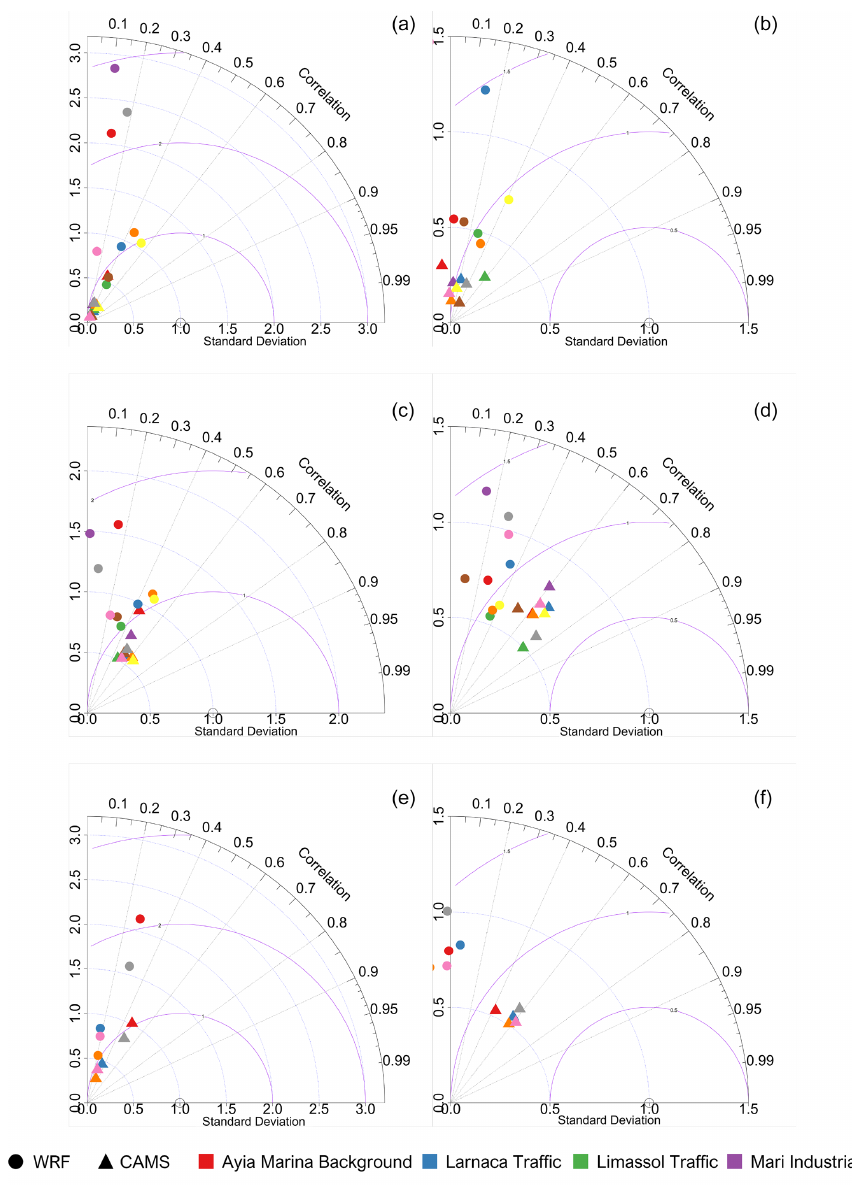
Figure 5. Taylor diagrams of NO 2 (a, b) , O 3 (c, d) , and PM 2 . 5 (e, f) for winter (a, c, e) and summer (b, d, f)